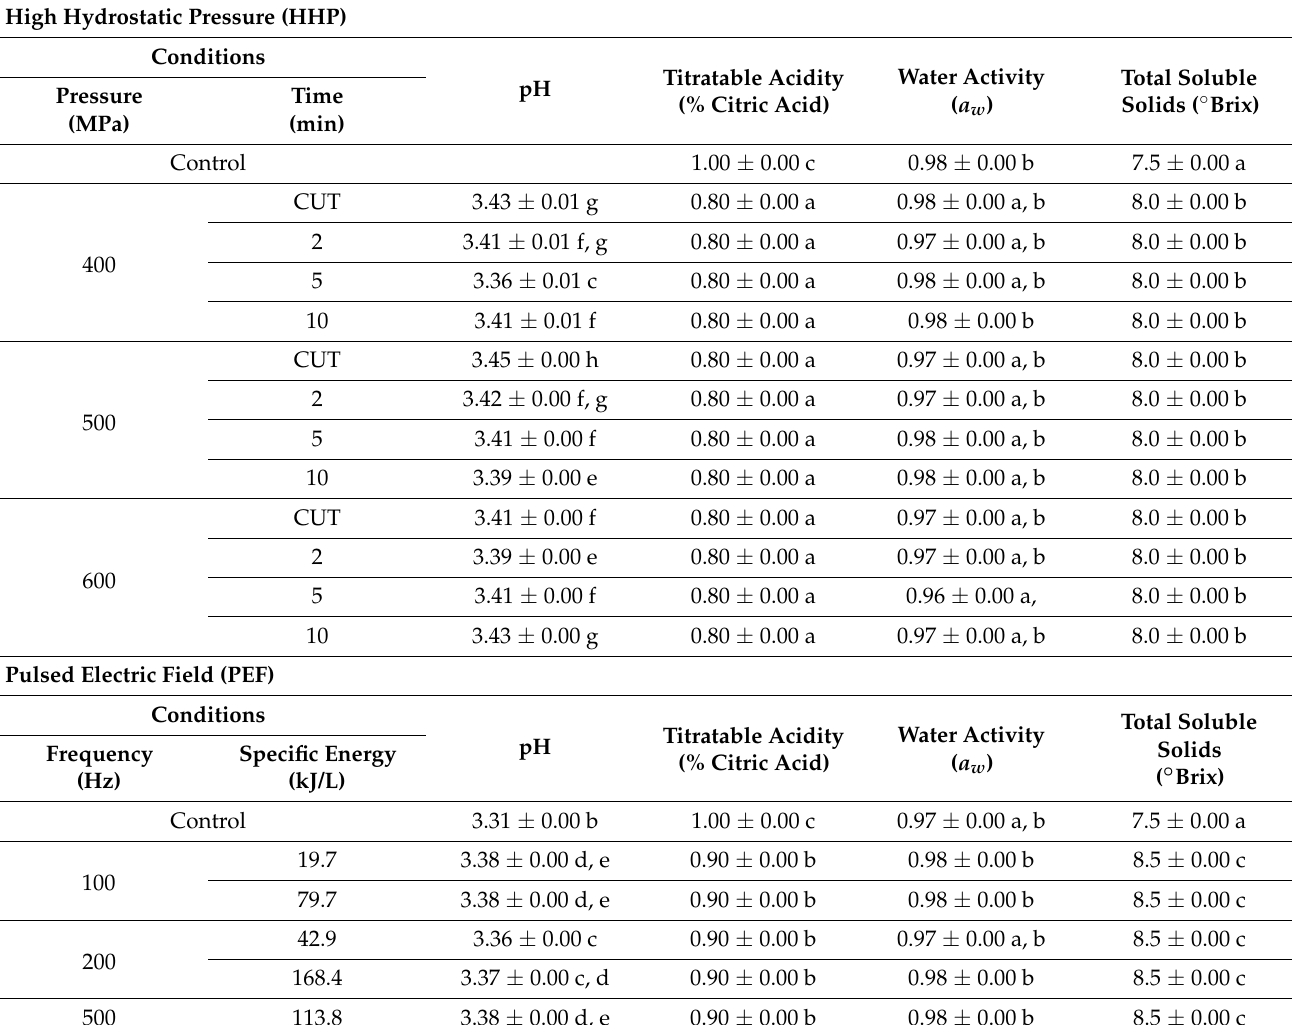
Table 2. Physicochemical parameters of the black/red raspberry juice HHP and